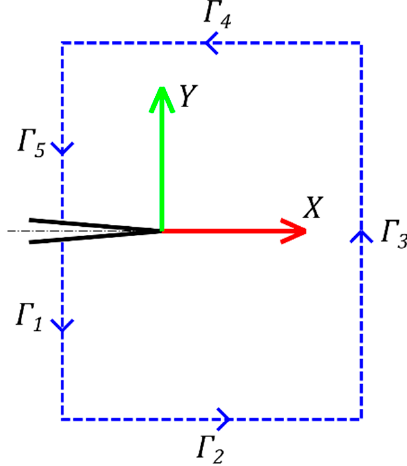
Figure 4. Rectangular path around the crack tip.